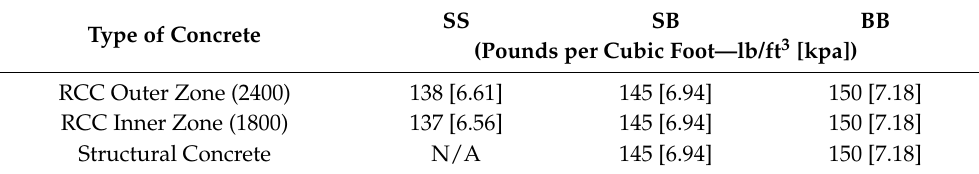
Table 3. Density of concrete for monoliths and structures.